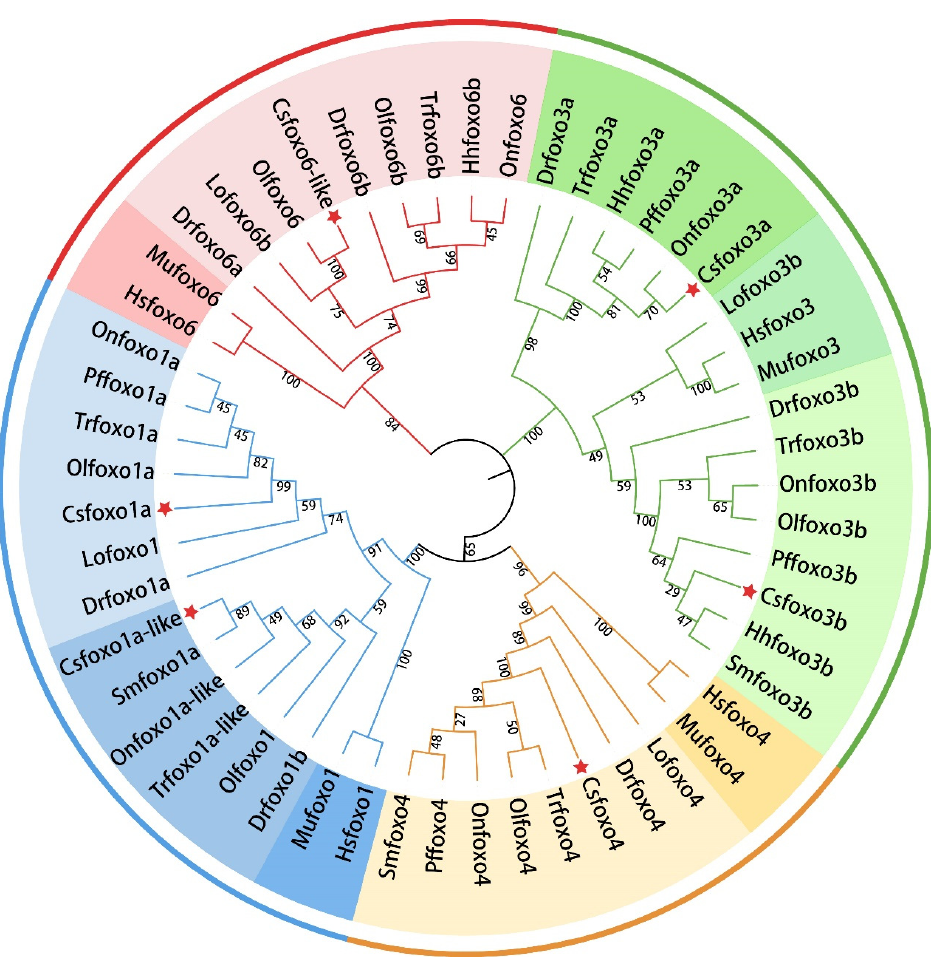
Figure 2. Phylogenetic trees of foxo from nine fish, Chinese tongue sole (Csfoxo), medaka (Olfoxo), turbot (Smfoxo), zebrafish (Drfoxo), spotted gar (Lofoxo), Nile tilapia (Onfoxo), fugu (Trfoxo), pufferfish (Pffoxo), and Atlantic halibut (Hhfoxo), and two mammals, mice (Mmfoxo) and humans (Hsfoxo). Different colors in the circle represent different fox members (blue for foxo1, red for foxo6, green for foxo3, orange for foxo4), and light color for fish and dark color for mammal. Red pentagrams indicate fox members of Chinese tongue sole.